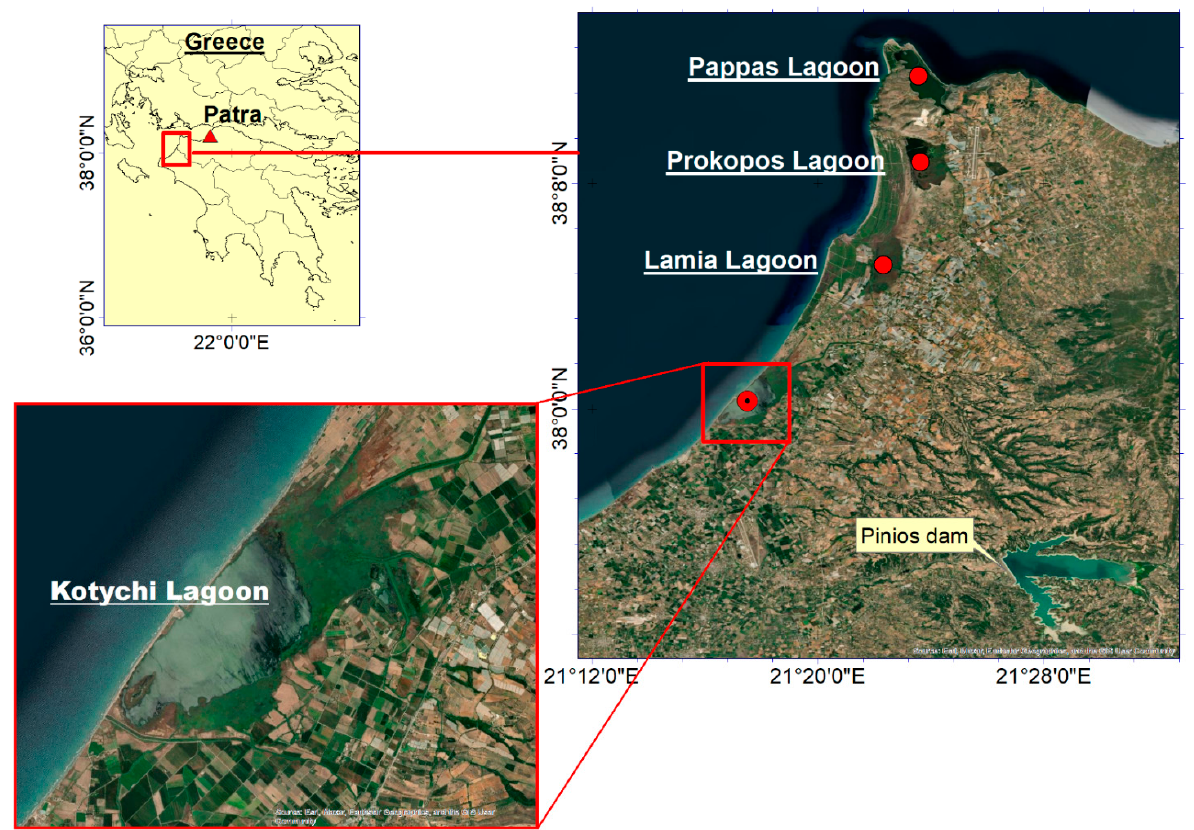
Figure 1. Wetlands of western Peloponnese and the location of the study area (Kotychi Lagoon).